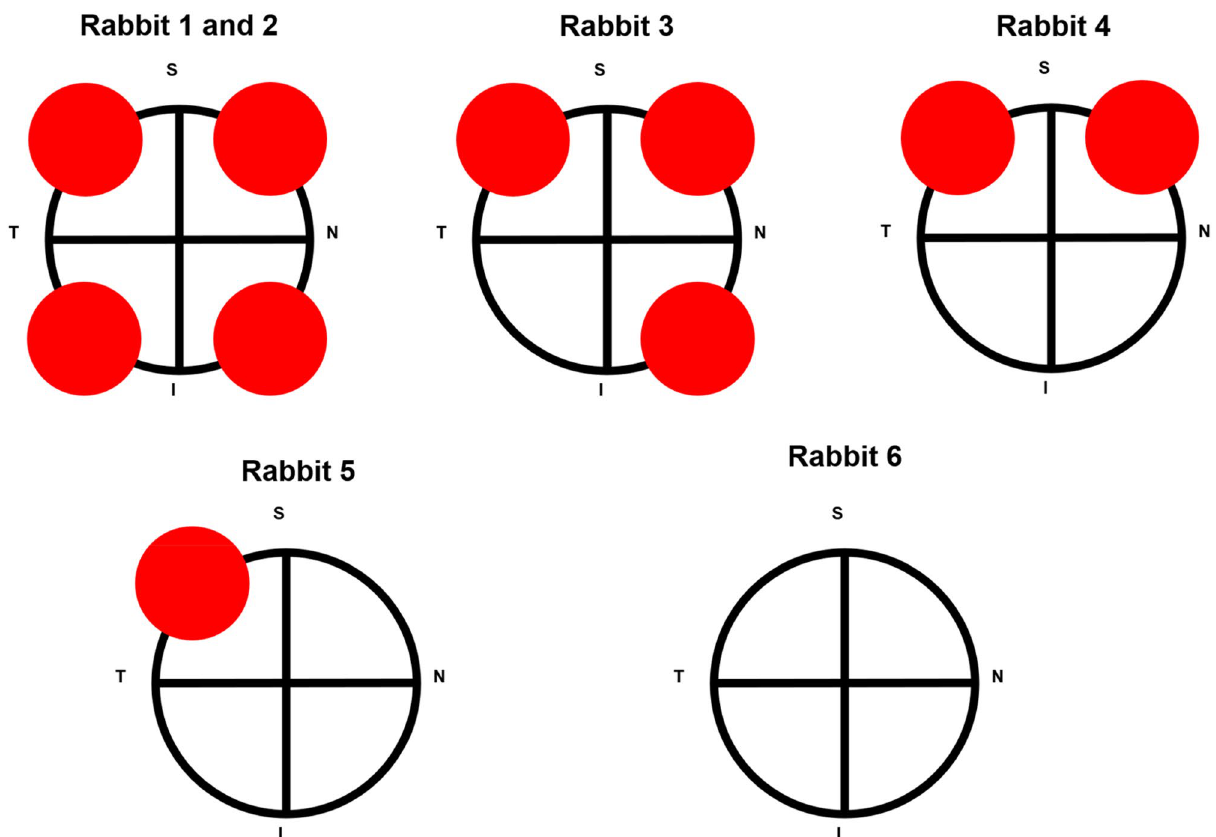
Figure 1. Schematic illustration of chemical ocular injury induced by alkali burns (represented by red circles as alkali-soaked filter paper discs, not to scale) using a previous described method 23 . N = Nasal. T = Temporal. S = Superior. I =